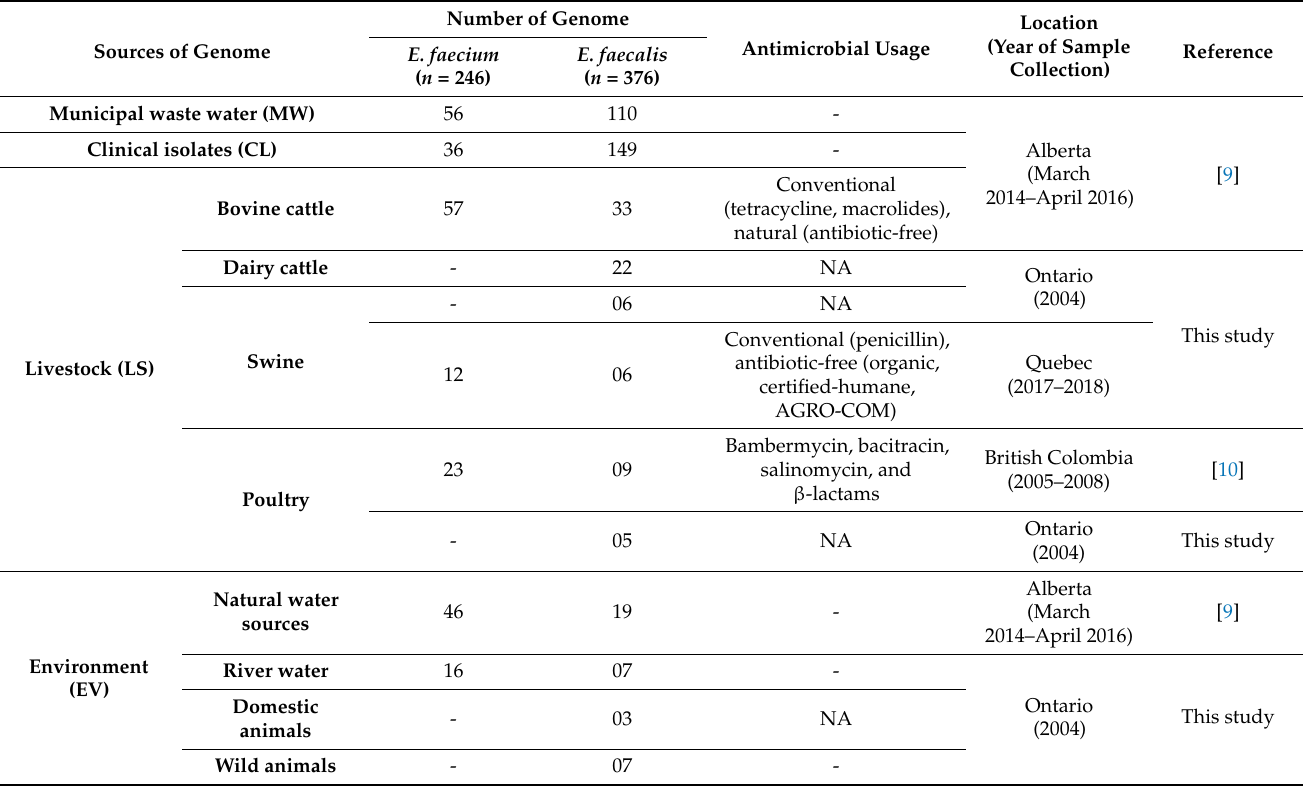
Table 1. Collection of Enterococcus faecium and Enterococcus faecalis genomes included in the compara- tive genomic analysis and antimicrobials used in